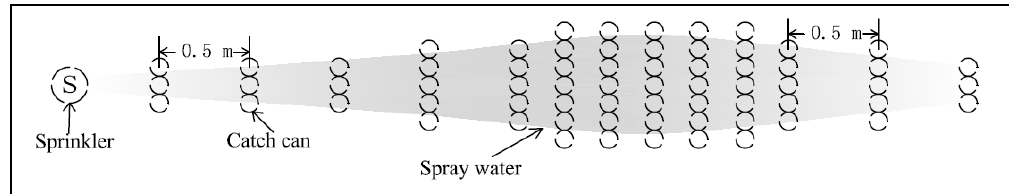
Figure 7. Experimental setup to determine the water distribution pattern from a single groove.